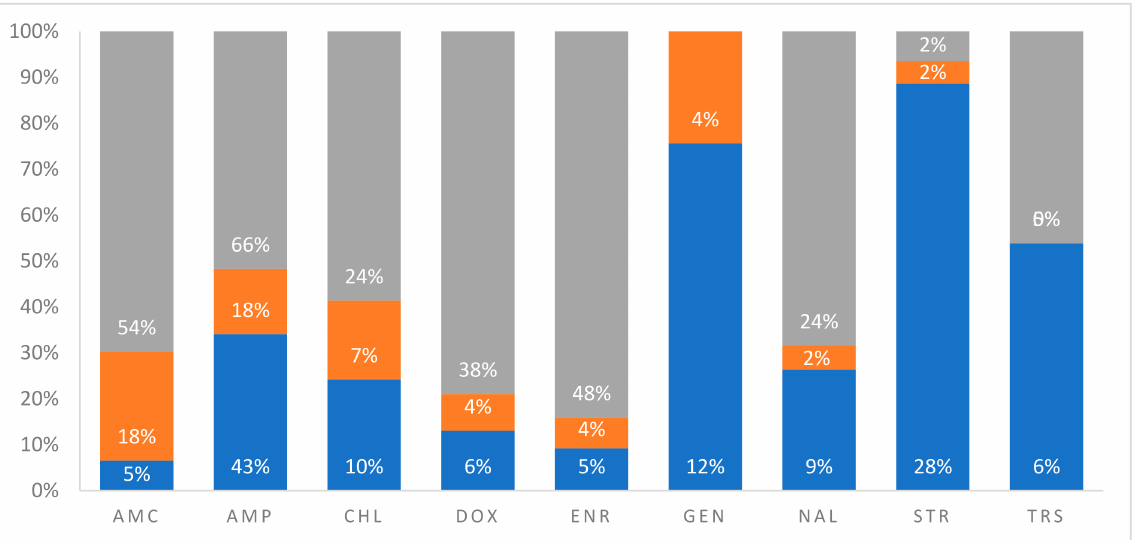
Figure 5. Percentage distribution frequency for AR to common antibiotics in bacteria isolated from sea turtles in differ- ent marine environments and stratification by potential sources of exposure as postulated by each original study. This includes rehabilitation centres for sick or injured turtles (grey), treated wastewater from WWTPs (blue), and other uniden- tified sources of anthropogenic pollutants (orange). Abbreviations are defined as: AMC = amoxicillin-clavulanic acid; AMP = ampicillin; CHL = chloramphenicol; DOX = doxycycline; ENR = enrofloxacin; GEN = gentamicin; NAL = nalidixic acid; STR = streptomycin; TRS =